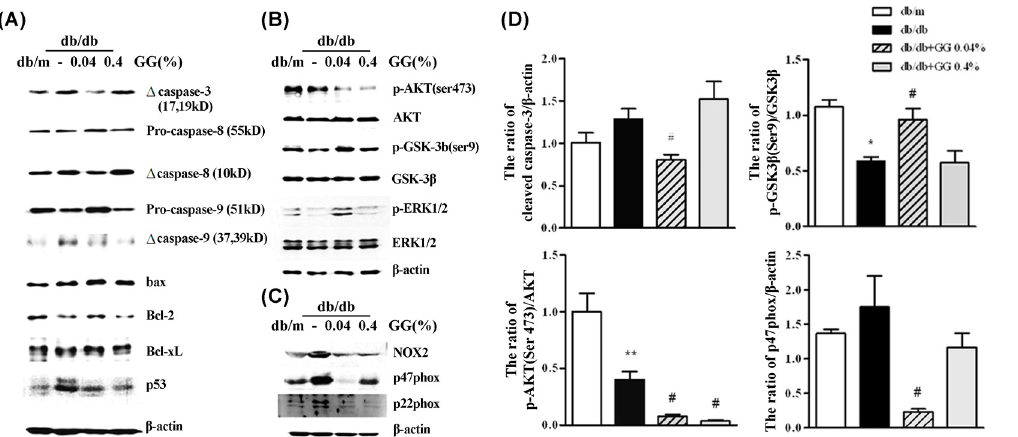
Fig 4. Gemigliptin (0.04%) attenuates apoptosis in the diabetic heart. Representative Western blot analysis of apoptosis-associated protein levels (A). The levels of phosphorylated AKT and GSK3 β (B) and of NADPH oxidase subunits (C). A bar graph (means ± SEMs) showing the changes in three or four animals per group (D). * p < 0.05, ** p < 0.01 vs. db/m; #p < 0.05 vs.